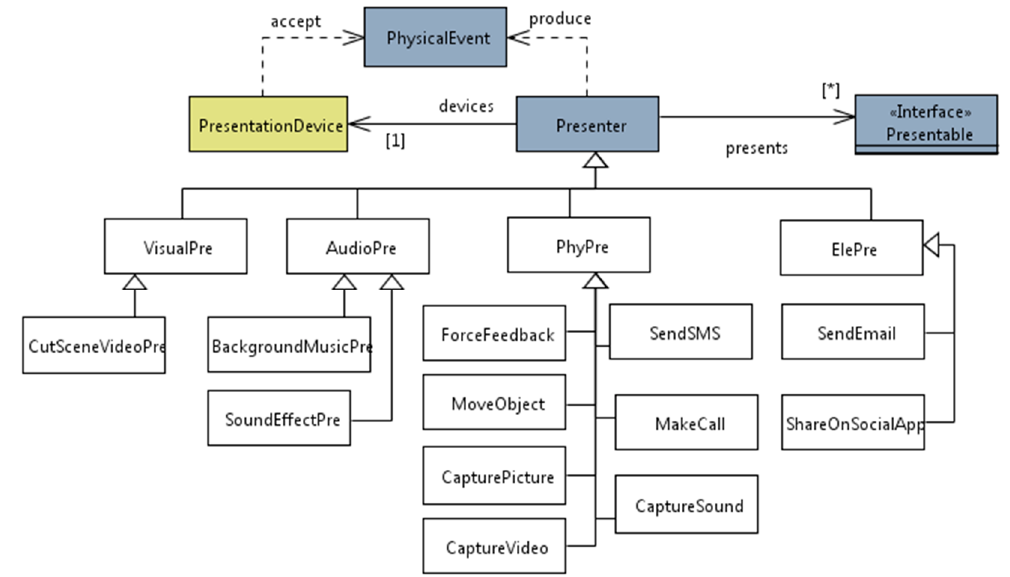
Figure 7. The pervasive game concepts in the presentation perspective.